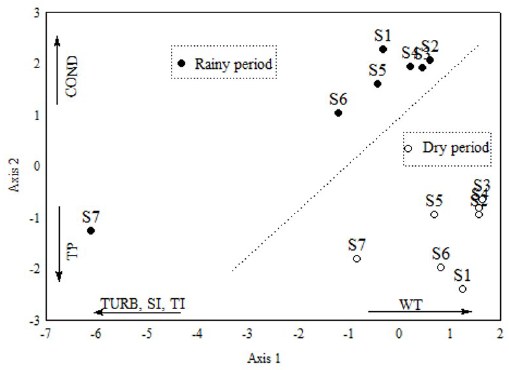
Figure 3. Dispersion of month-sites scores along the first two axes of the Principal Components Analysis performed with environmental variables measured in the João Leite reservoir, GO, Brazil, during a dry and rainy period (TP - total phosphorus; COND - electrical conductivity; WT - water temperature; TURB - turbidity; SI - soluble iron; TI - total iron; S - sampling sites).